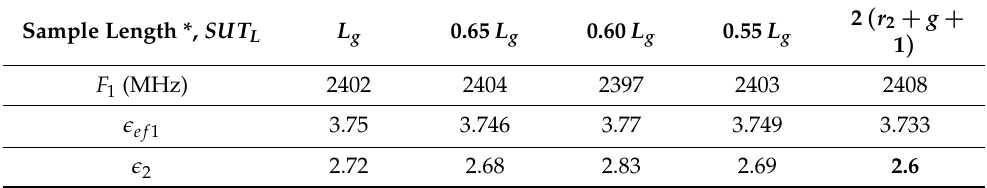
Table 4. Analyzing resonant frequencies for reduced sample width ( SUT W = 2 r 2 ) and variable sample length, SUT L